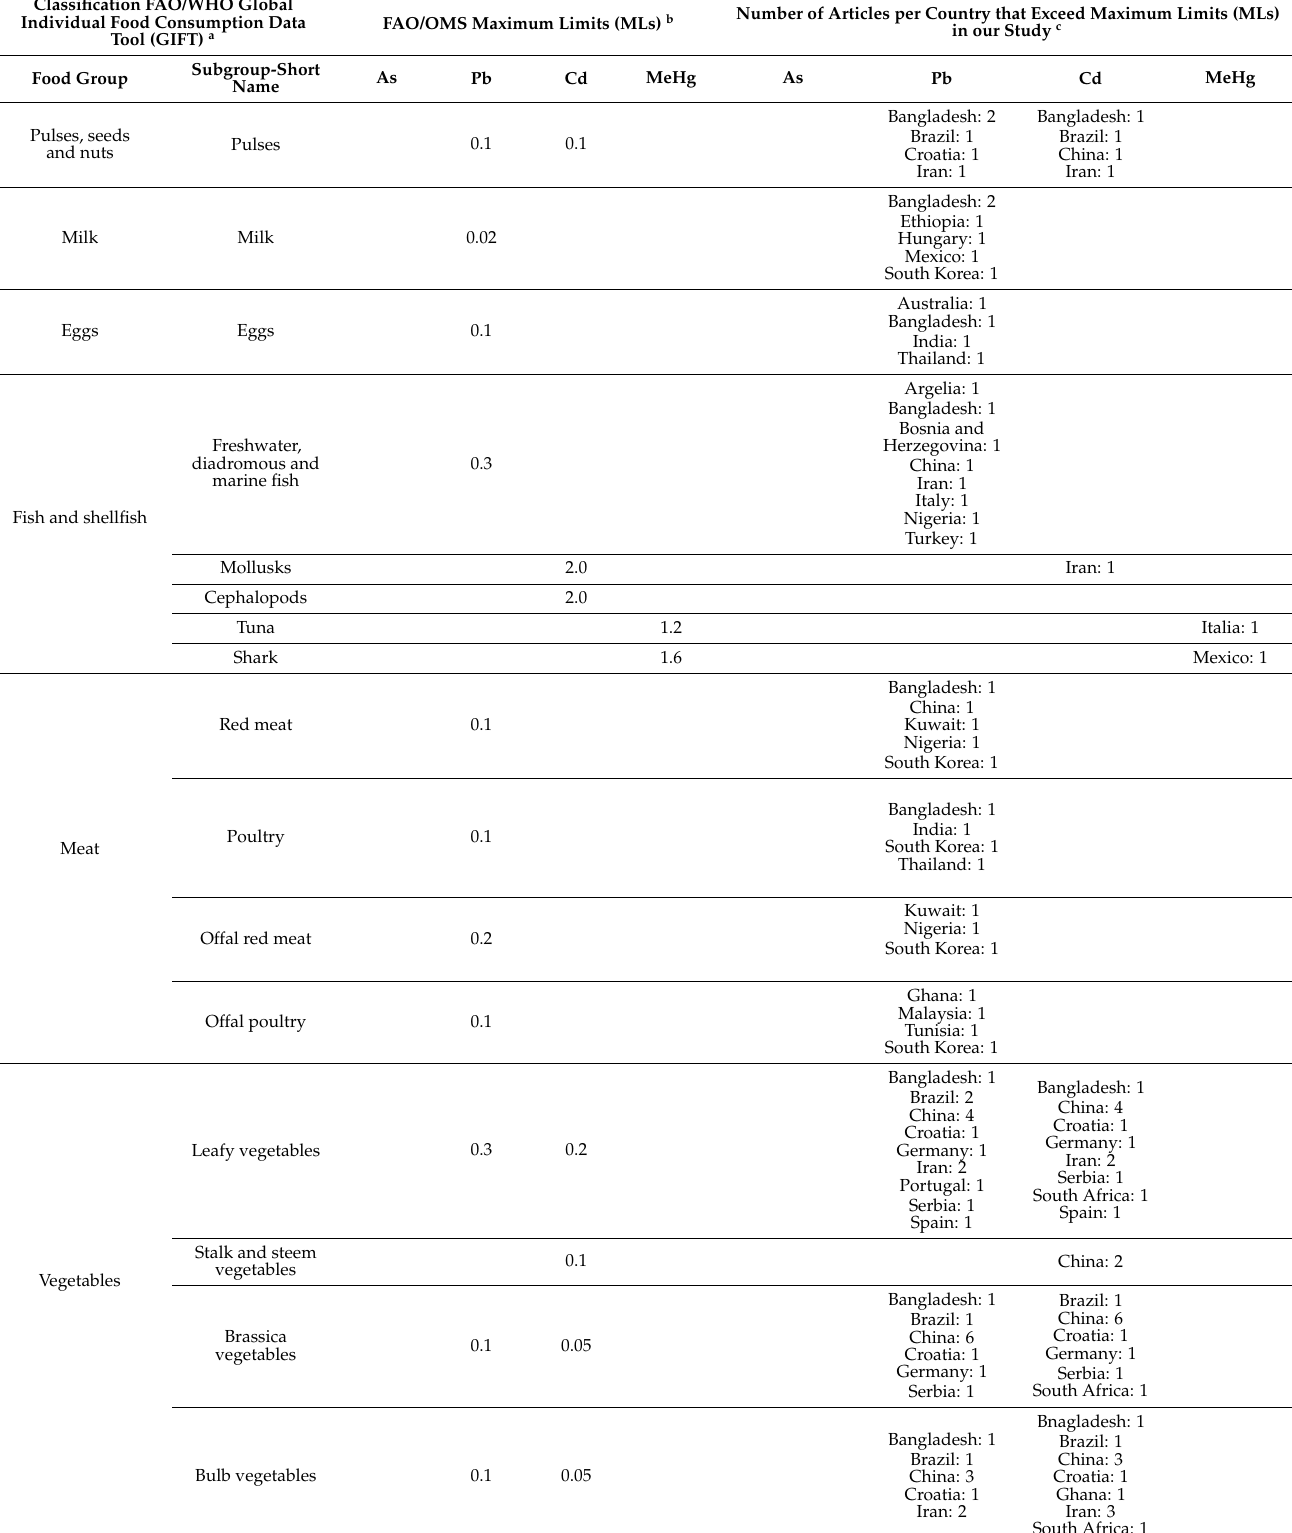
Number of Articles per Country that Exceed Maximum Limits (MLs) in our Study